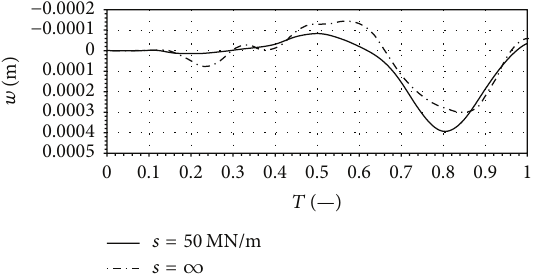
Figure 26: Dynamic deflection of point “c” (middle of the third span).